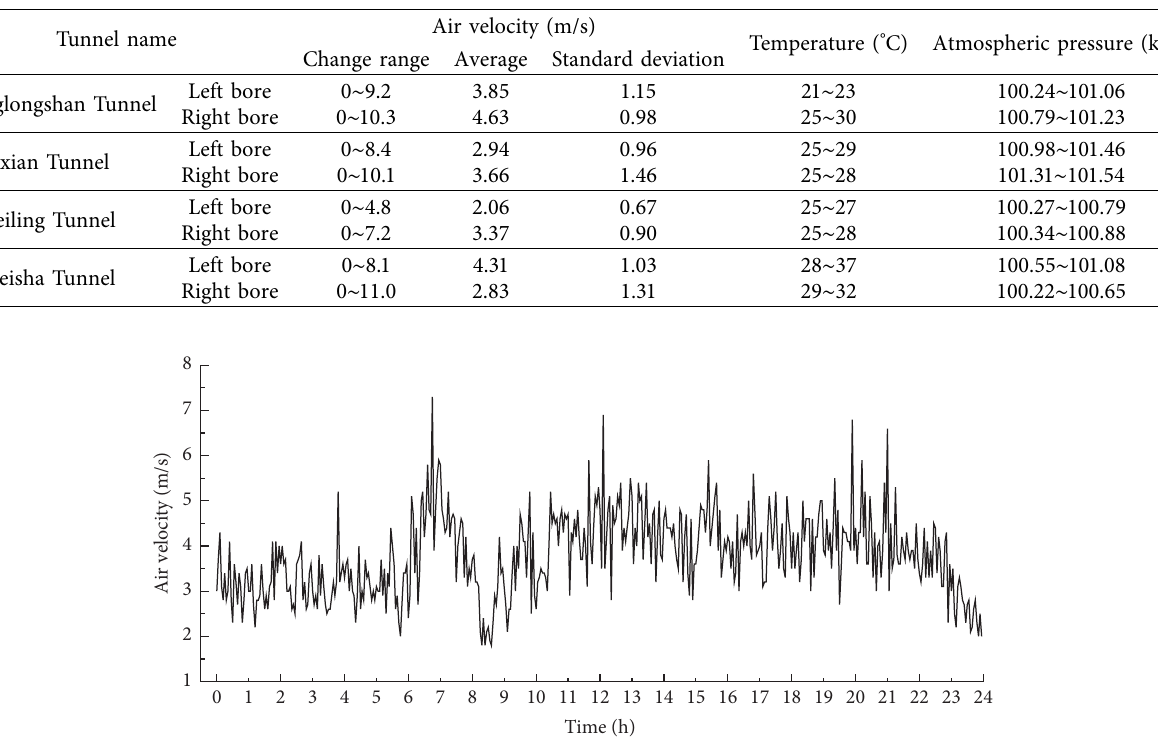
Figure 6: Diurnal profile of air velocity in the left bore of Henglongshan Tunnel (Apr 4,